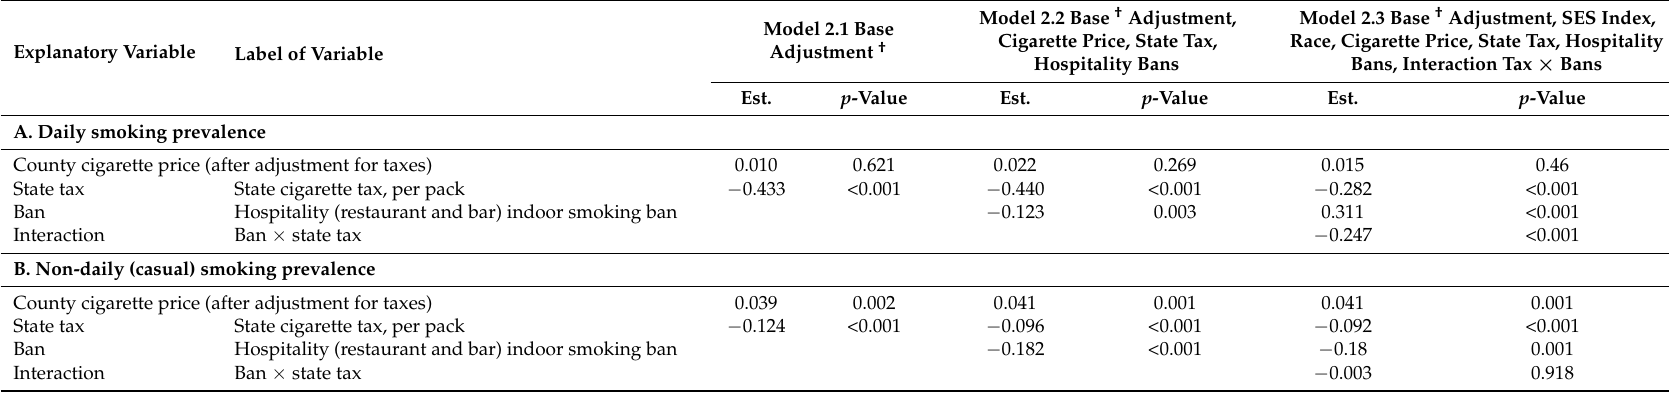
Table 3. Adjusted mean difference in county-level smoking prevalence according to cigarette price, state tax, hospitality ban and interactions, data from 2001 to 2011, n = 477 U.S. counties. Estimates are derived from a random intercept model *